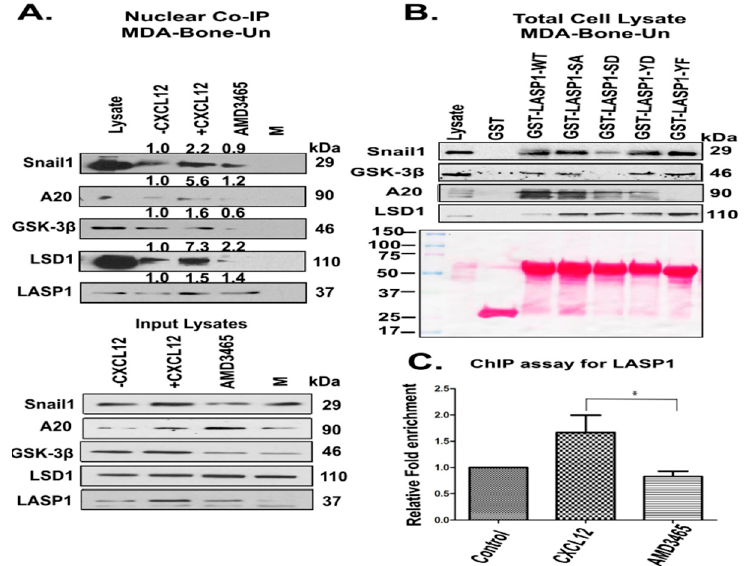
Figure 4. ( A ) Nuclear LASP1 co-immunoprecipitated with Snail1 and proteins that regulate the stability of Snail1 endogenously in response to CXCL12; ( A ) Co-immunoprecipitation of LASP1 with Snail1 and its regulators—Top panel: Serum-starved MDA-Bone-Un cells were stimulated with 20 nM CXCL12 for 20 min. In some conditions, Bone-Un cells were pre-incubated with the CXCR4 antagonist AMD-3465 for 30 min prior to the addition of the ligand CXCL12. LASP1 was immunoprecipitated with mouse anti-LASP1 (8C6 clone) antibodies from 250 µg of the nuclear extracts from MDA-Bone-Un cells and analyzed by 10% SDS-PAGE followed by immunoblotting for associated Snail1, A20, GSK-3 β , and LSD1. ‘M’ represents the mock co-immunoprecipitation performed with isotype control IgG1 antibodies. Bottom panel: 15 µg of nuclear lysates were resolved by 10% SDS-PAGE, and immunoblotted for Snail1, A20, GSK-3 β , LSD1 and LASP1 blot. ( B ) Differential association of phosphorylated forms of LASP1 to endogenous Snail1 and its regulators—1.5 nmol of each of the GST, LASP1-WT and its phosphomimetic (S146D and Y171D) and phosphonull (S146A and Y171A) mutants fused to GST were incubated with 250 µg of nuclear lysate derived from CXCL12-stimulated MDA-Bone-Un cells. The differential association of endogenous Snail1, GSK-3 β , A20 and LSD1 with full length LASP1-WT and its mutants were analyzed by 10% SDS-PAGE, followed by immunoblotting; n = 3. ( C ) Occupancy of LASP1 at the E-cadherin promoter region—Serum-starved MDA-Bone-Un cells were stimulated with 20 nM CXCL12 for 20 min. In some conditions, Bone-Un cells were pre-incubated with the CXCR4 antagonist AMD-3465 for 30 min prior to the addition of the ligand CXCL12. The chromatin fragments were prepared and subjected to chromatin immunoprecipitation (ChIP) analysis. The data from quantitative, real-time PCR were statistically analyzed and shown as the Mean ± SD, n = 3 independent biological repeats; * p < 0.05.